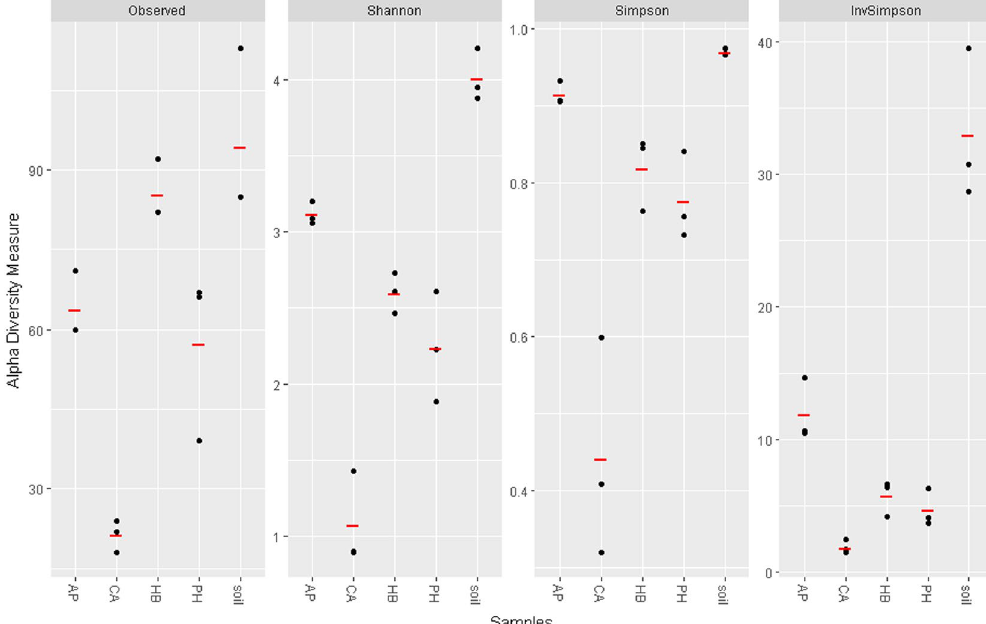
Figure 4. Number of observed sequence variants and diversity indexes of the microbial communities from the original soil or microbial populations enriched on each SPME (acetophenone AP ; trans -cinnamic acid CA ; p -hydroxybenzoic acid HB ; phenethyl alcohol PH ; each dot represents one biological replica, mean values are shown as red bars). Abbreviations: Observed – number of observed sequence variants, Shannon – Shannon- Wiener index, Simpson – Simpson’s index of diversity (1– D ), InvSimpson – Inverse Simpson’s index (1/ D